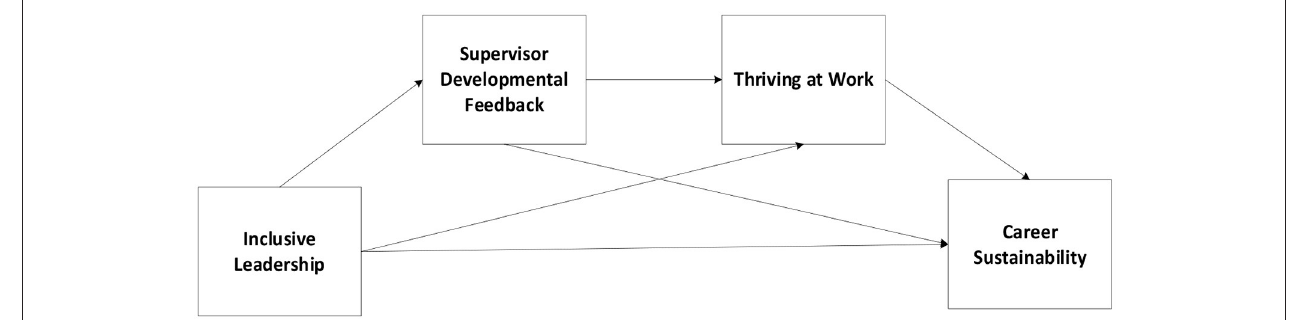
FIGURE 1 | Theoretical